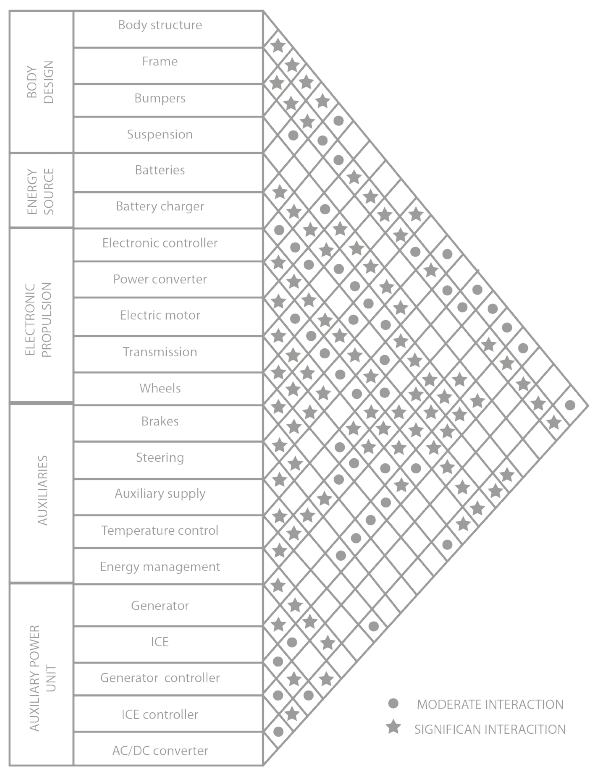
Figure 13. Key components and